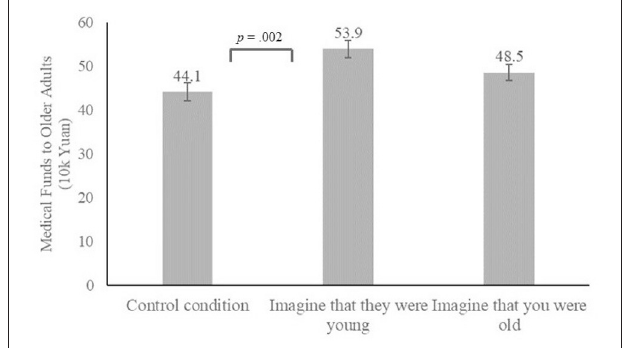
FIGURE 2 | Hostile ageism behavior across three conditions. Error bars stand for the SEM.